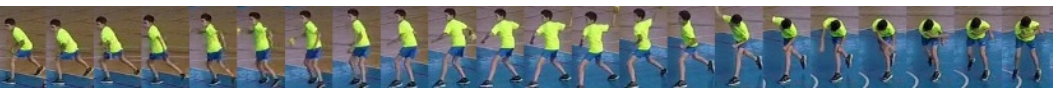
Figure 8. Detected most active player (white thick bounding box) and his trajectory through the whole sequence (yellow line).